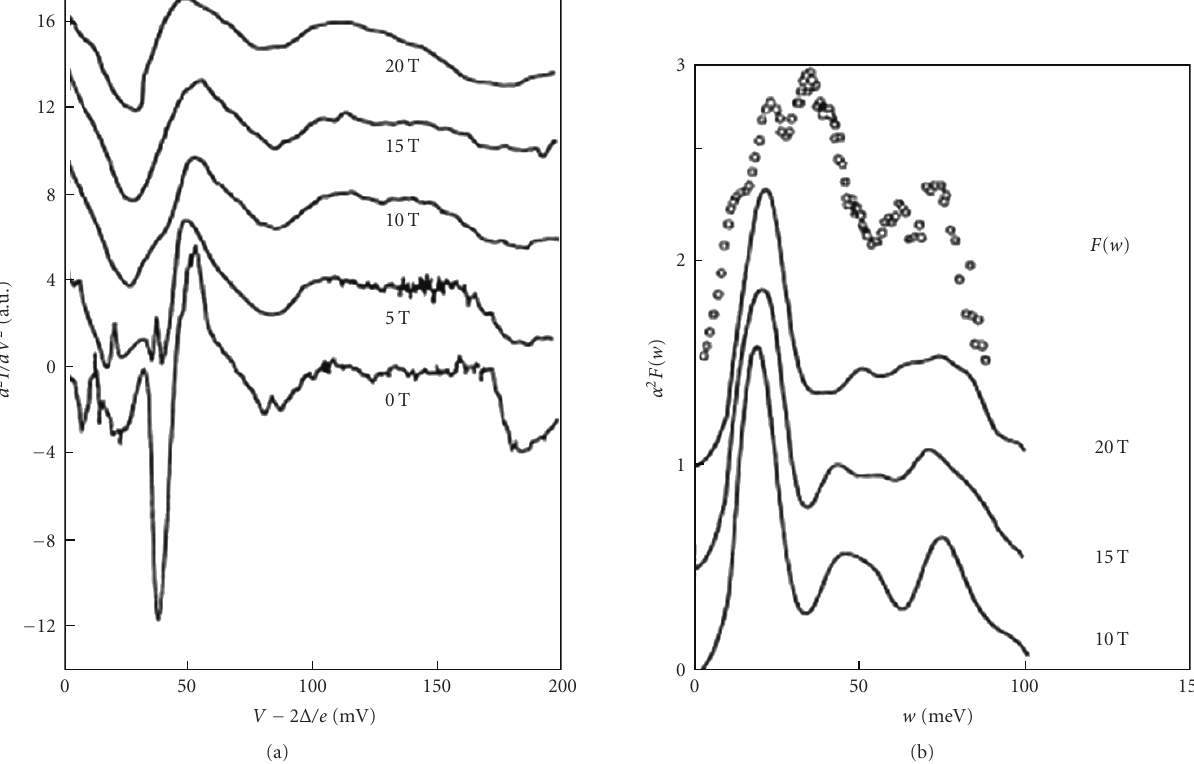
Figure 21: (a) Second derivative of I ( V ) for a Bi 2212 break junction in various magnetic fields (from 0–20 T ). The structure of dips (minima) in d 2 I/dV 2 can be compared with the phonon density of states F ( ω ); (b) the spectral functions α 2 F ( ω ) in various magnetic fields. From [42–